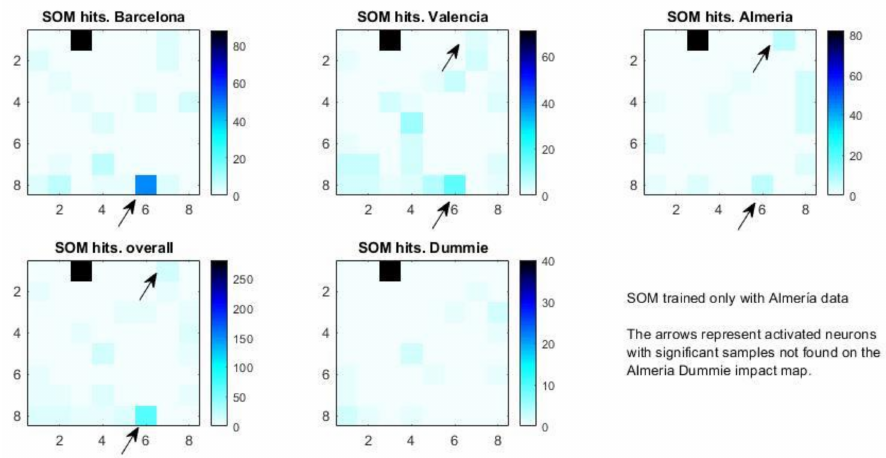
Figure 6. Impact maps of data collected in each city, and of non-significant data (Almer í a “Dummie”). The impact maps show activated groups in certain neurons that are characteristic of the samples in which a singular building has been rehabilitated. The distance grows significantly around the reference neuron, indicating a very different type of model from the rest of the samples. In order to understand the name of each element in the network, these are numbered from 1 to 64, arranged in 8 columns by 8 rows. The first element in the network (please note that the term neuron and network element are used interchangeably to refer to each of the elements that make up the self-organizing map) is in the upper left corner and the last element in the lower right